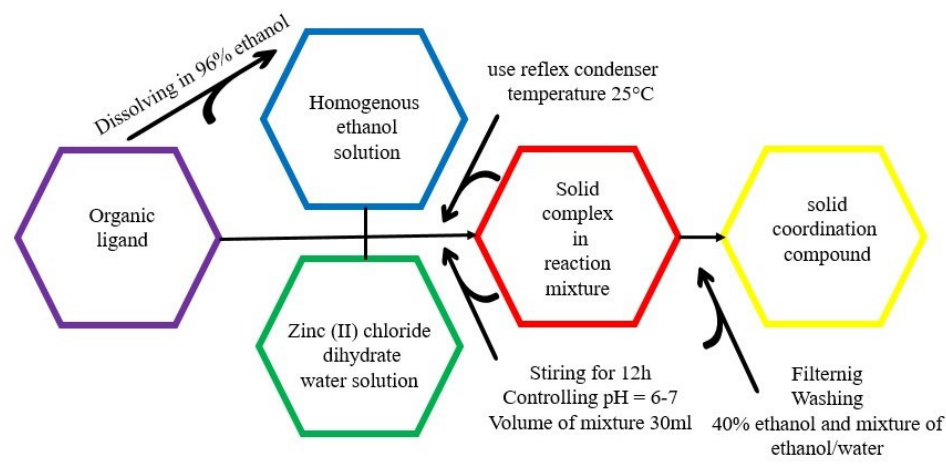
4 of 20 Table 1. Percentage composition of the elements in coordination compounds. C1 [Zn 2 Cl 4 (L1) 2 ] ∙ 2H 2 O (C 22 H 20 N 8 O 2 Zn 2 Cl 4 )